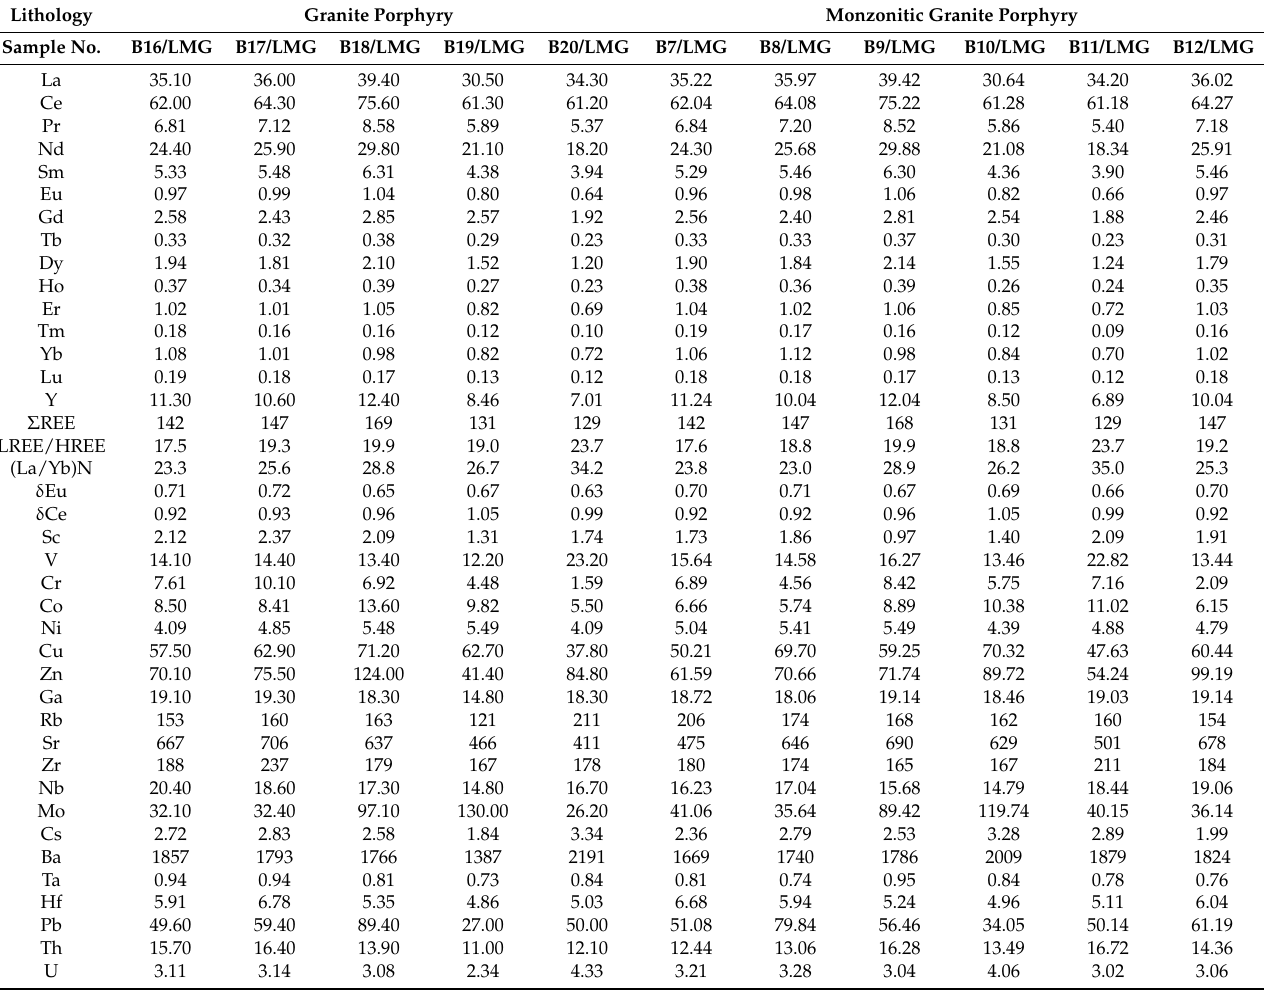
Table 3. Trace elements(10 − 6 )of the Leimengou granite porphyry and monzonitic granite